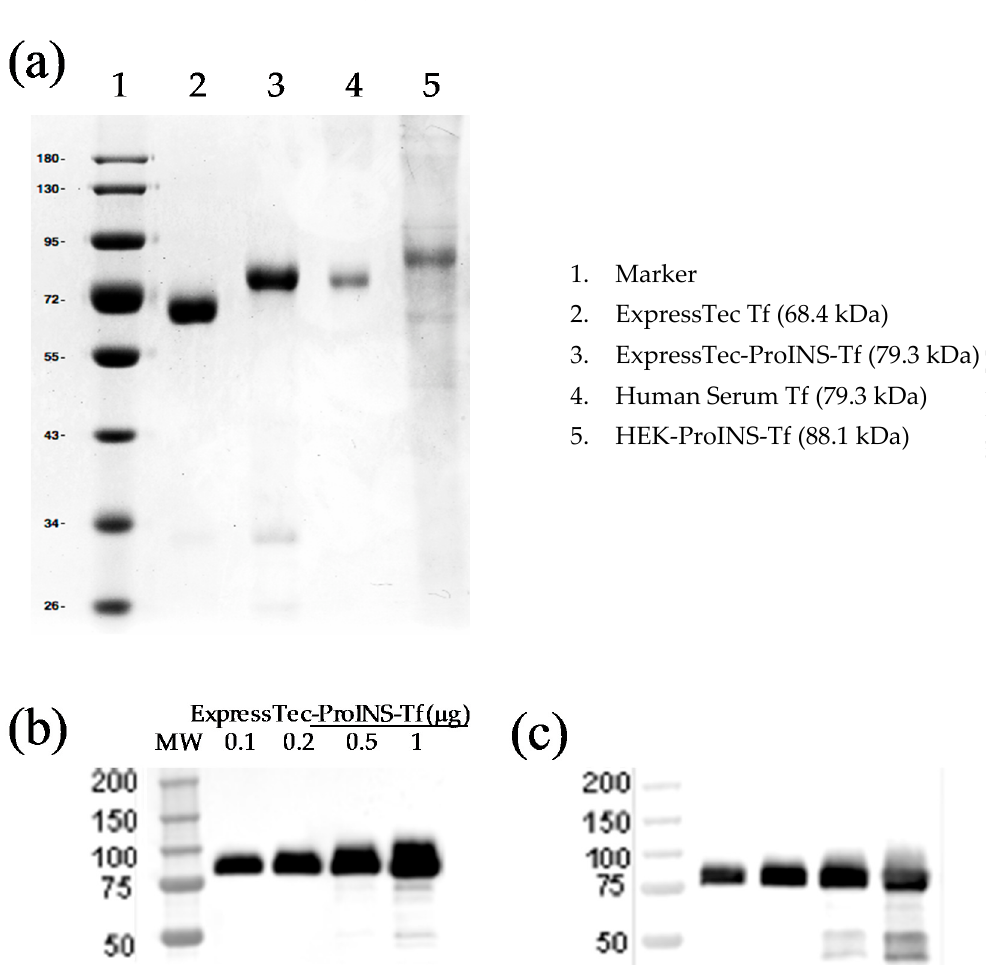
Figure 2. Molecular characterization of ExpressTec ProINS-Tf. ( a ) 10% SDS-PAGE followed by Coomassie blue staining. The indicated molecular weights were estimated by Image Lab TM Software ( b ) Western blot probed with anti-ProINS antibody. 0.1, 0.2, 0.5 and 1 μ g of ExpressTec-ProINS-Tf were loaded, respectively. ( c ) Western blot probed with anti-Tf antibody. 0.1, 0.2, 0.5 and 1 μ g of ExpressTec-ProINS-Tf were loaded, respectively.